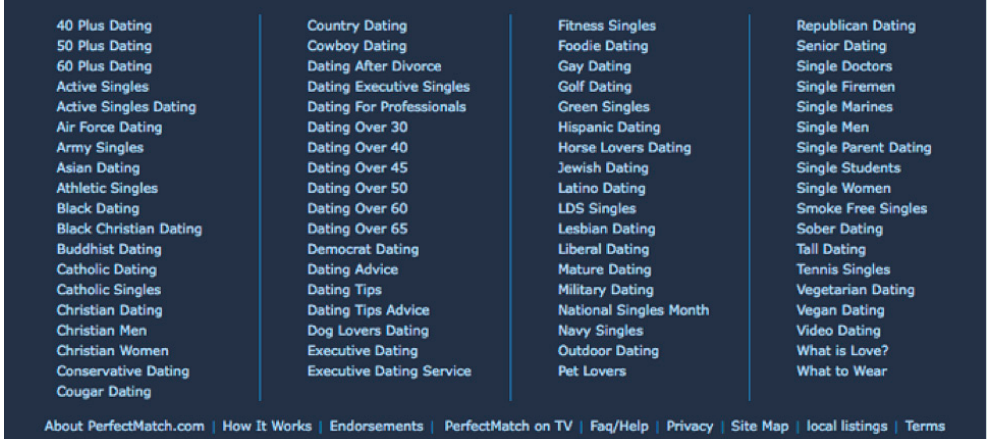
Figure 1. List of niche offerings from PerfectMatch.com [33].